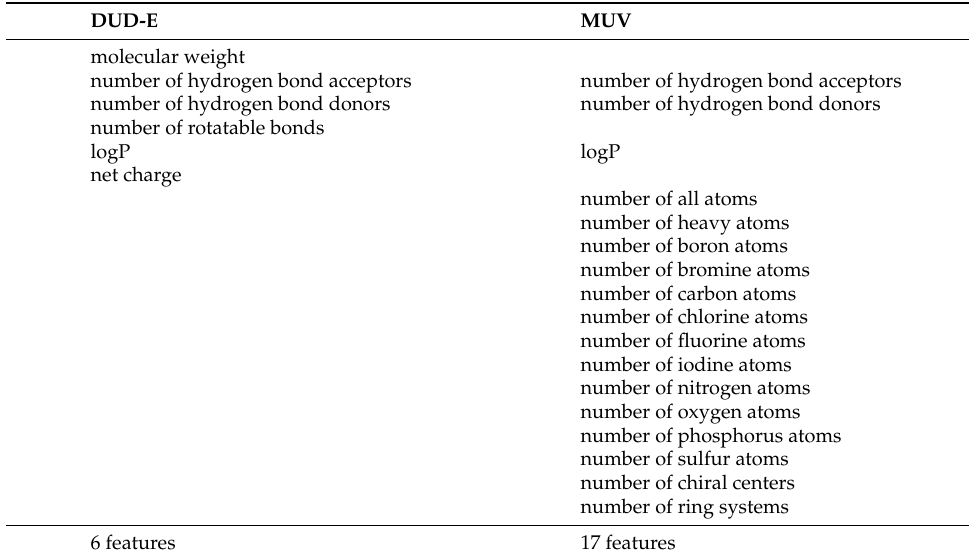
Table 1. Descriptors used in the construction of DUD-E and